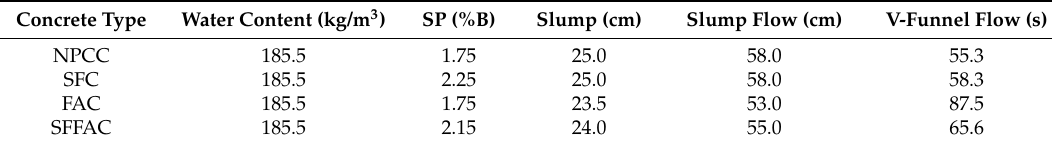
Table 2. Key fresh properties of different concrete